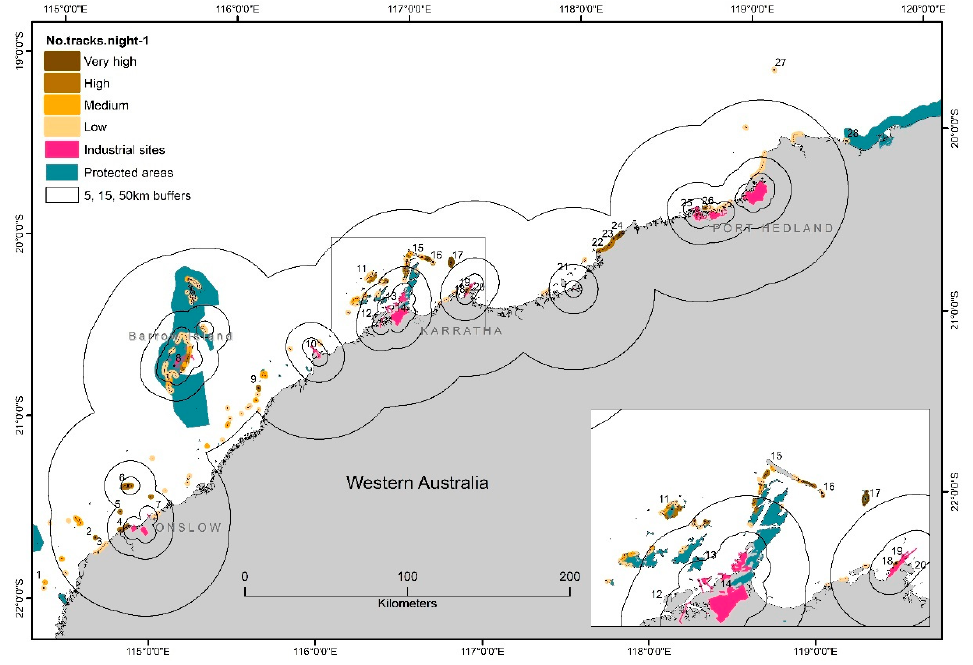
Figure 3. Abundance (number of tracks · night − 1 ) estimates of fresh (0–36 h. old) flatback turtle tracks at beaches in the Pilbara region of Western Australia obtained via digital aerial photography between 29th November and 6th December 2016. Spatial exposure to industrial activity and inclusion in protected areas illustrated as defined in the legend. Footprints of industrial sites are shown in pink with 5, 15 and 50 km buffers as black lines. Protected areas are show in green. (1) Y Island, (2) Locker Island, (3) Urala Beach, (4) Ashburton Delta, (5) Ashburton Island, (6) Thevenard Island, (7) Beadon Creek-Onslow, (8) Barrow Island, (9) Long Island, (10) Cape Preston, (11) Rosemary Island, (12) West Intercourse Island, (13) East Lewis Island, (14) Dampier town, (15) Legendre Island, (16) Hauy Island, (17) Delambre Island, (18) Cape Lambert, (19) Bells Beach, (20) Point Samson, (21) Forestier Islands, (22) Cape Cossigny-Mundabullangana, (23) Cowrie Beach west-Mundabullangana, (24) Cowrie Beach main-Mundabullangana, (25) Downes Island, (26) Cemetery Beach-Port Hedland, (27) Bedout Island, and (28) Mulla Mulla Downs Creek. Inset map (grey rectangle) highlights beaches 11 to 20.